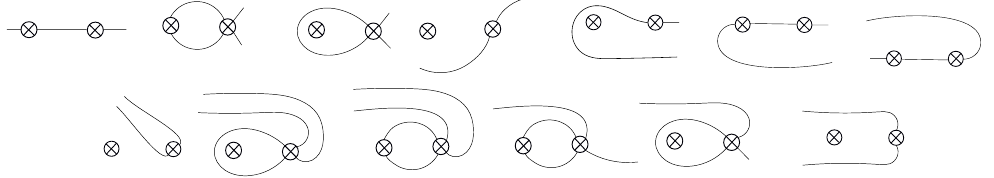
Figure 25. Arcs compatible with property Q